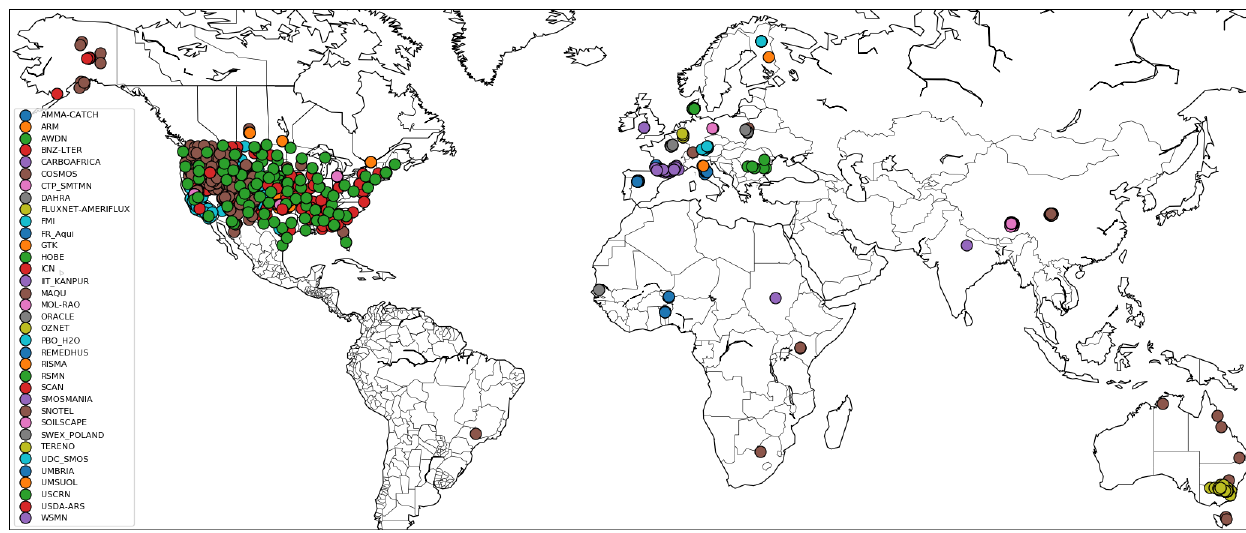
Figure 8. Locations of the ISMN stations used for product evaluation. Colours represent different measurement networks.